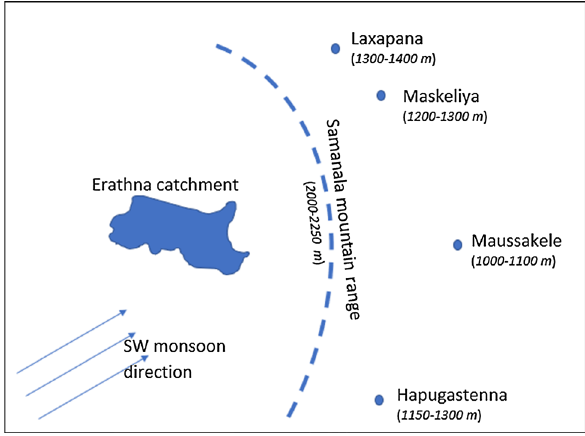
Fig. 3 Erathna catchment and Samanala mountain